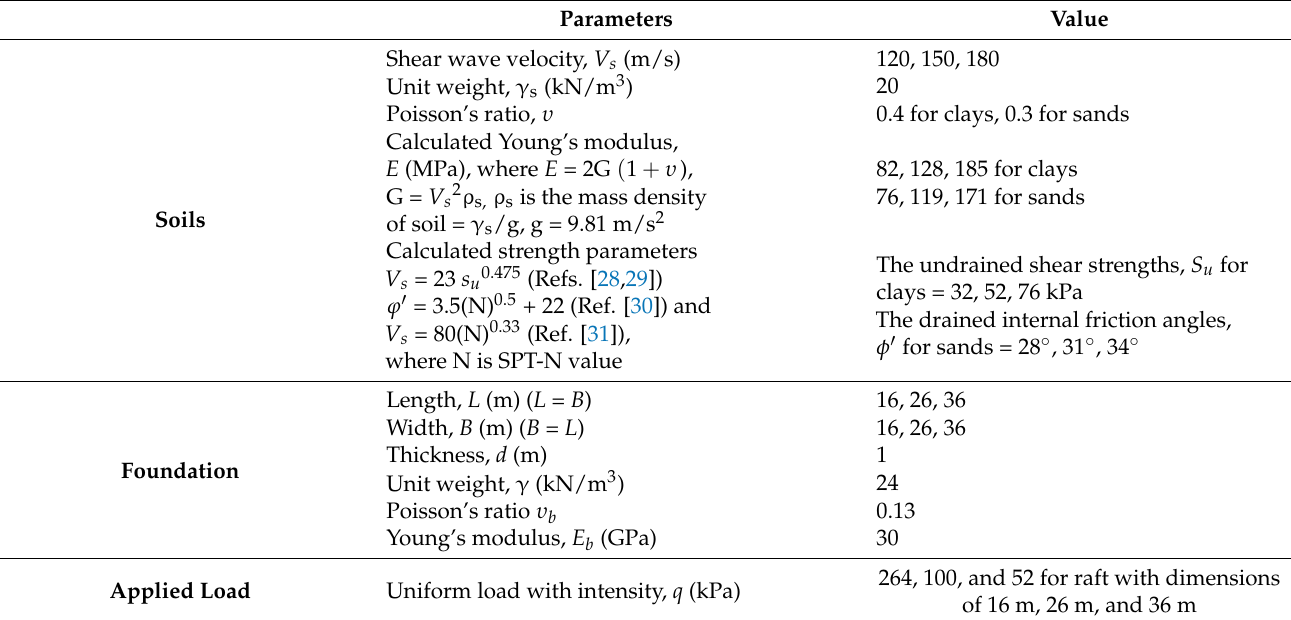
Table 1. Parameters of the numerical